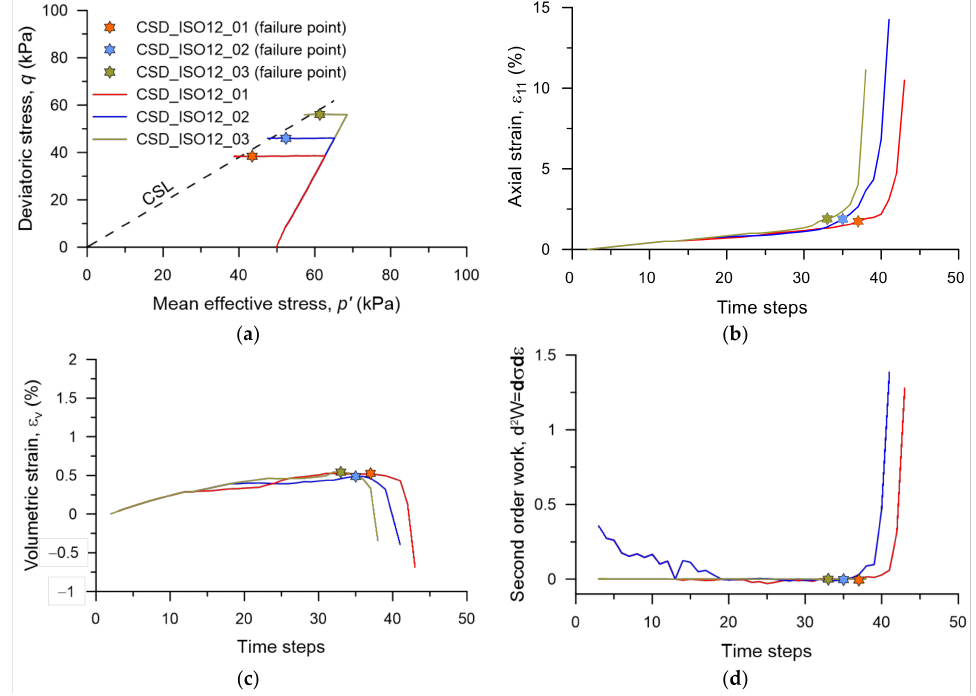
Figure 8. The CSD simulations with the same initial state with ISO12 in ( a ) q - p (cid:48) , ( b ) ε 11 , ( c ) ε v and ( d ) d 2 W